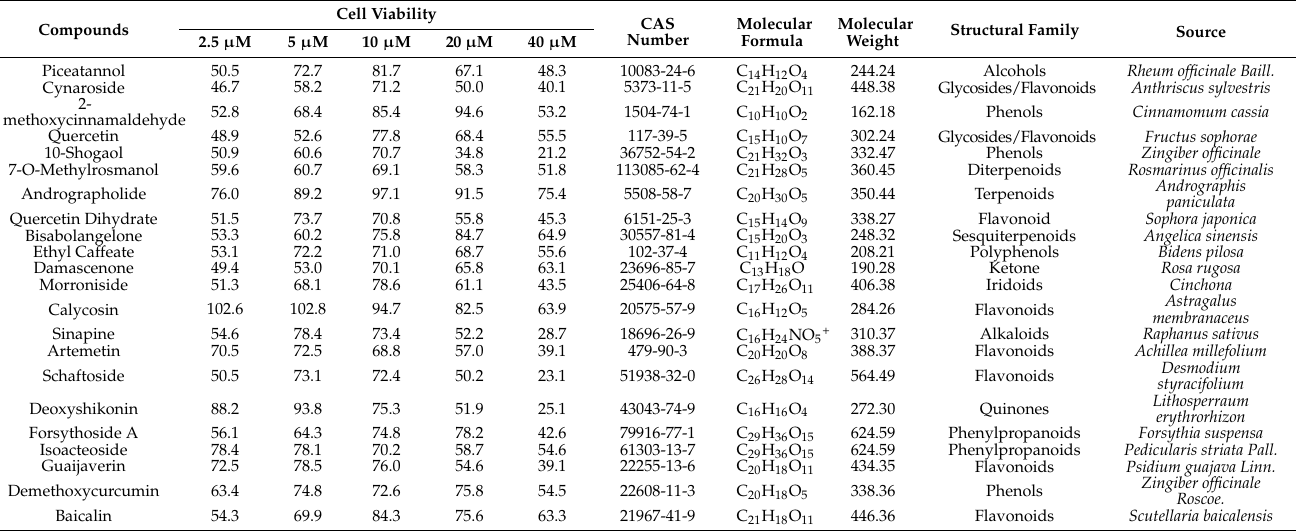
Table 1. The cell viability and characteristics of the identified 22 hits at the indicated concentration.